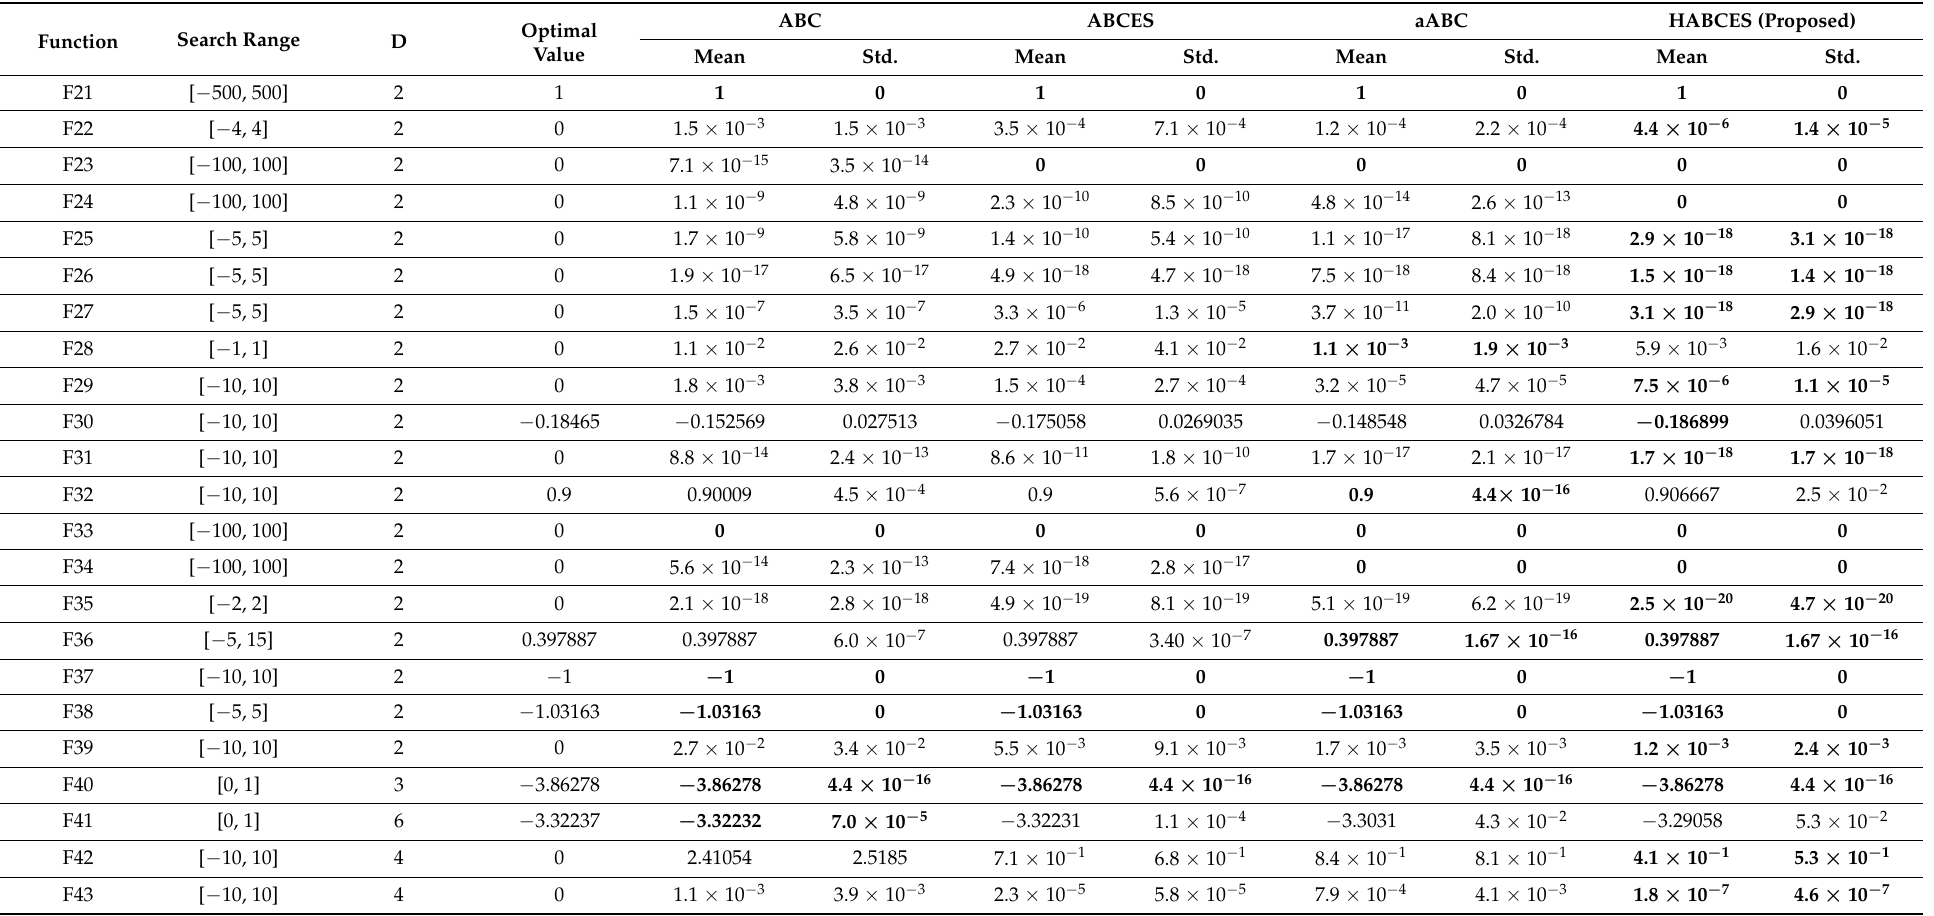
Table 3. Comparison of the results of the ABC, aABC, ABCES and the HABCES algorithms when solving low-dimensional global optimization